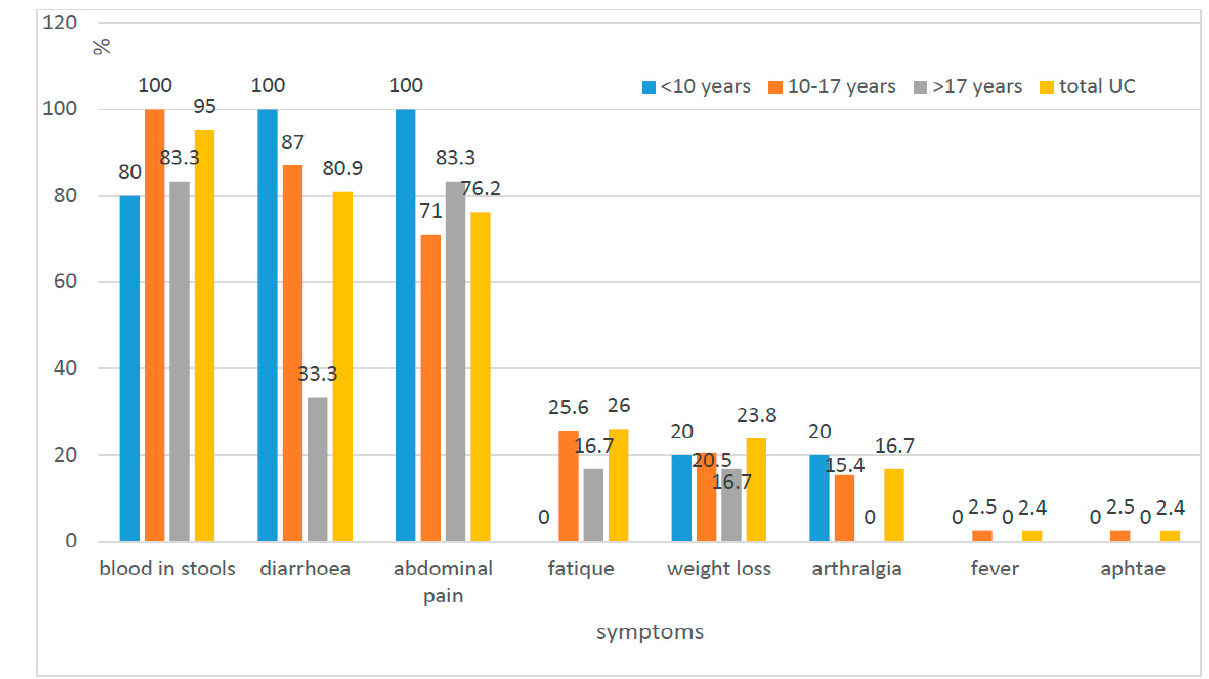
Figure 3. Correlation between symptoms and age (UC—ulcerative colitis).